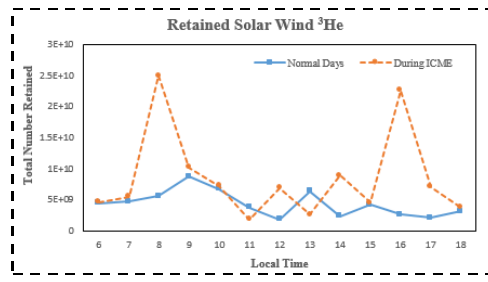
Figure 6. Total retained 3 He during ICME and that of the normal days. A net higher retention is observed during